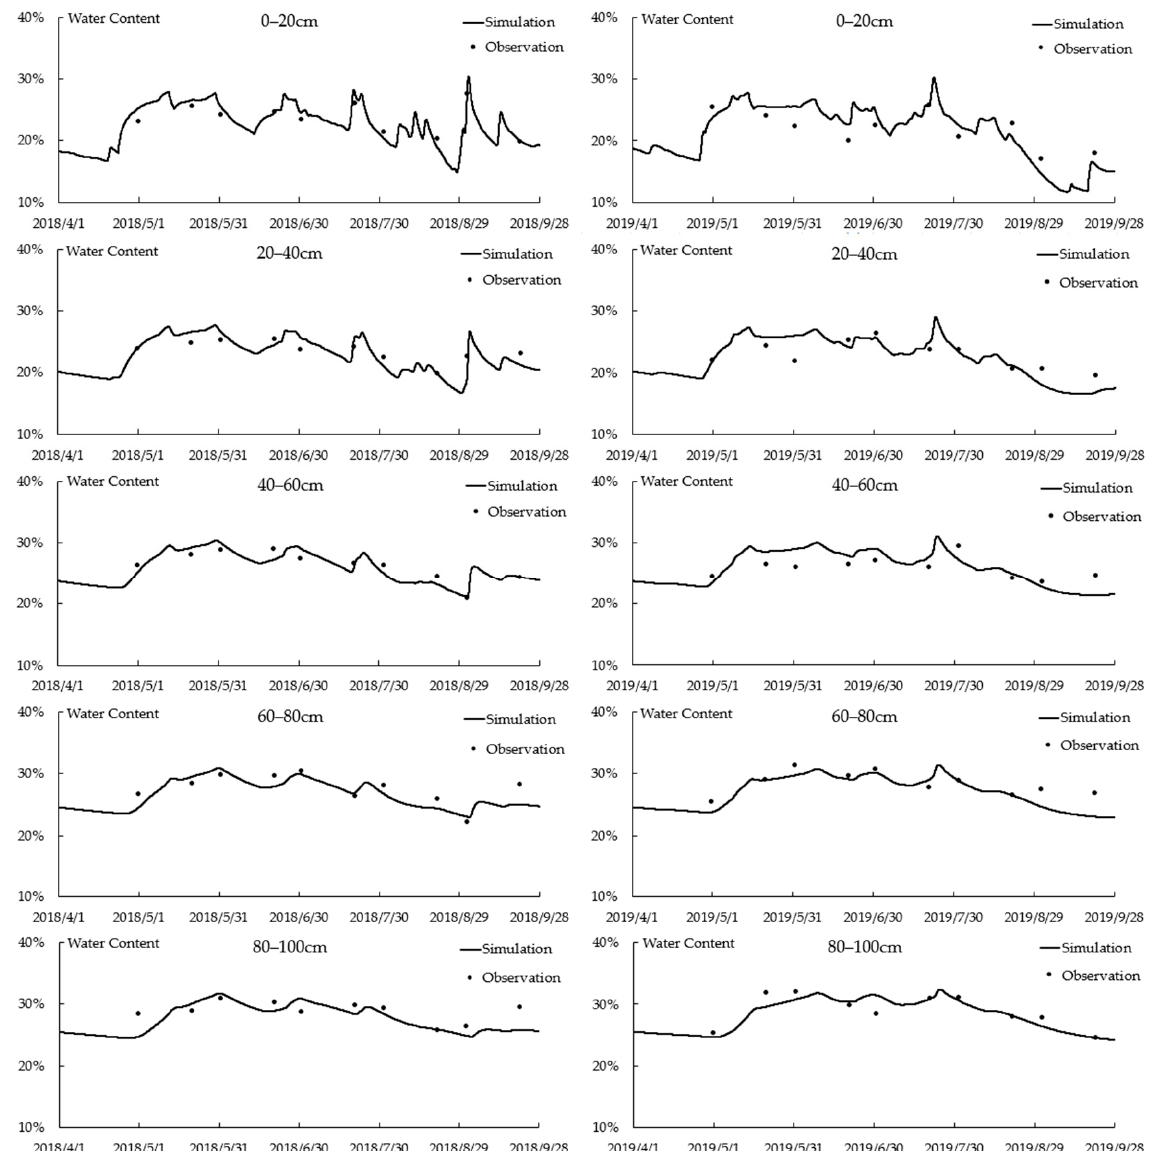
Figure 10. Process of simulated and observed soil water content at 5 layers of an observation site.